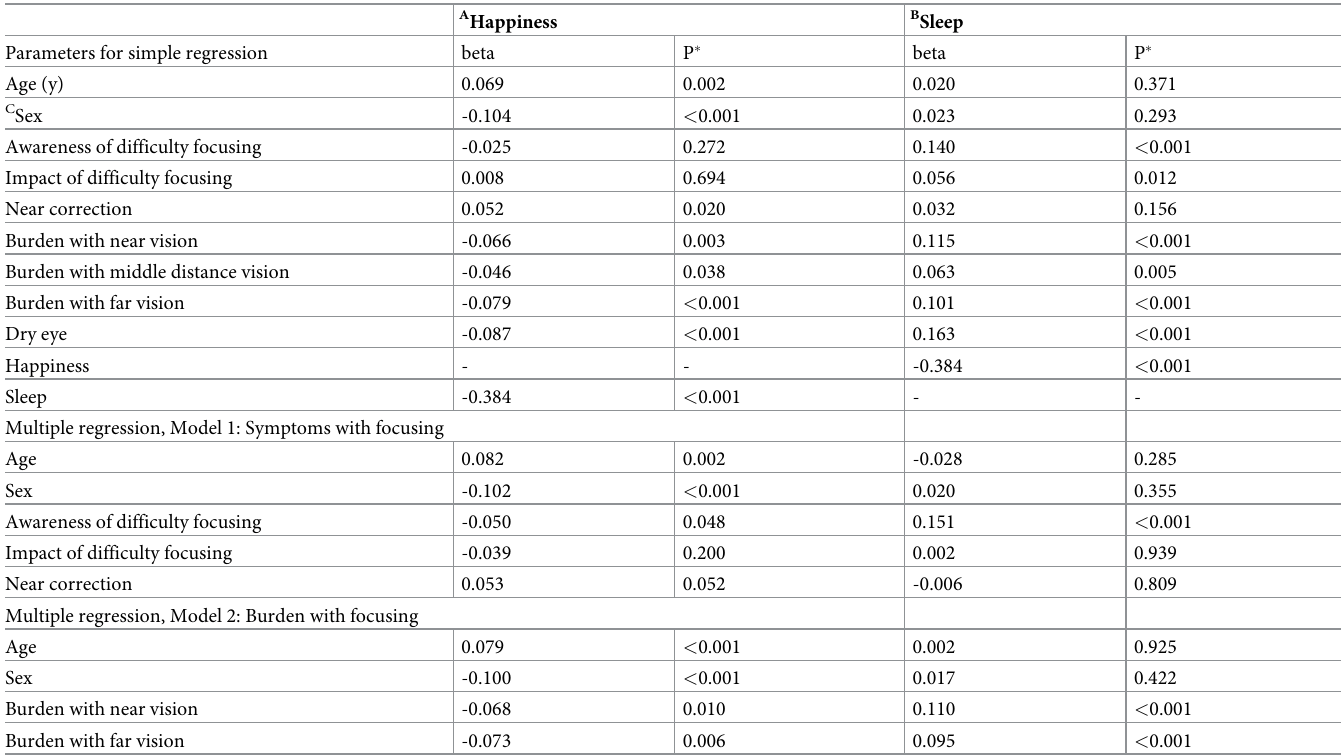
Table 4. Regression analysis for happiness and